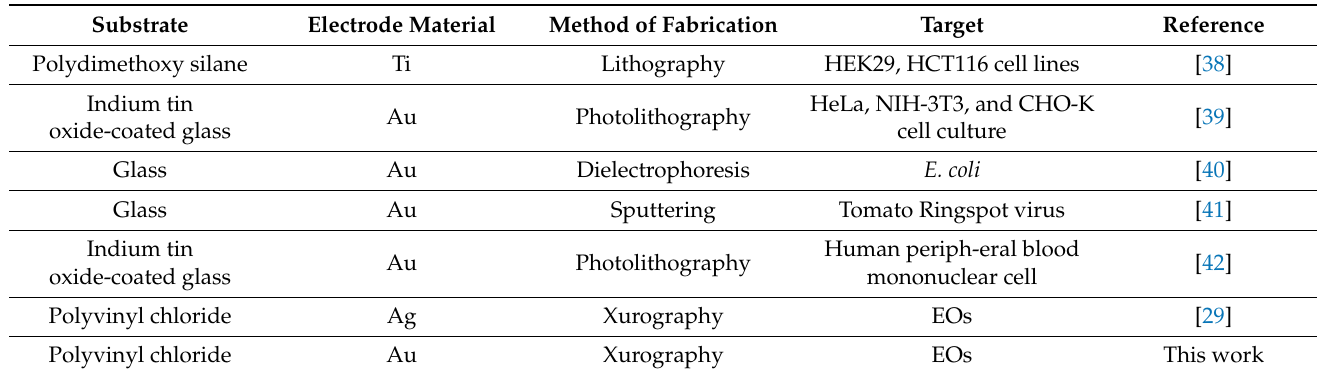
Table 4. Application of microfluidic systems in sensing using impedance